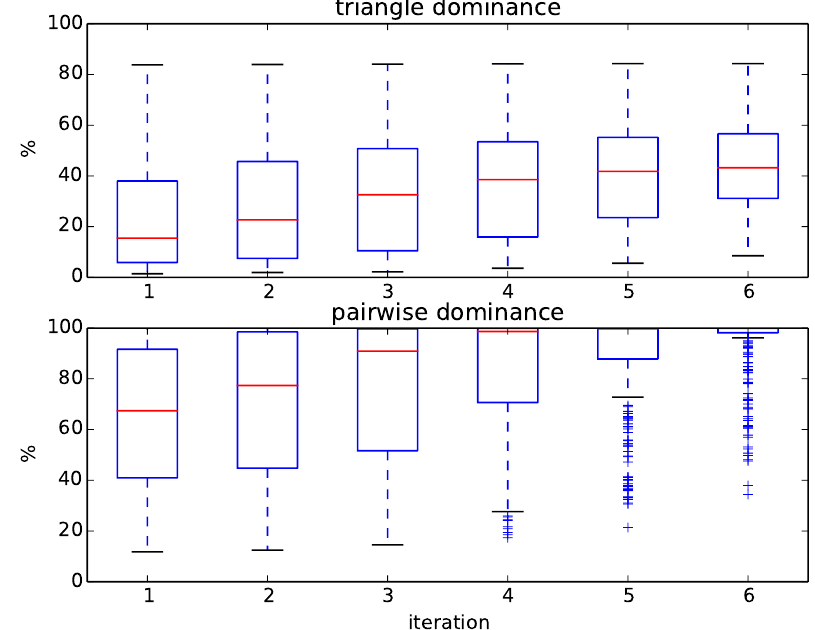
Figure 6. Boxplots of the percentage of removed targets at each iteration during triangle and pairwise dominance for the 236 queries of the SCOPCath